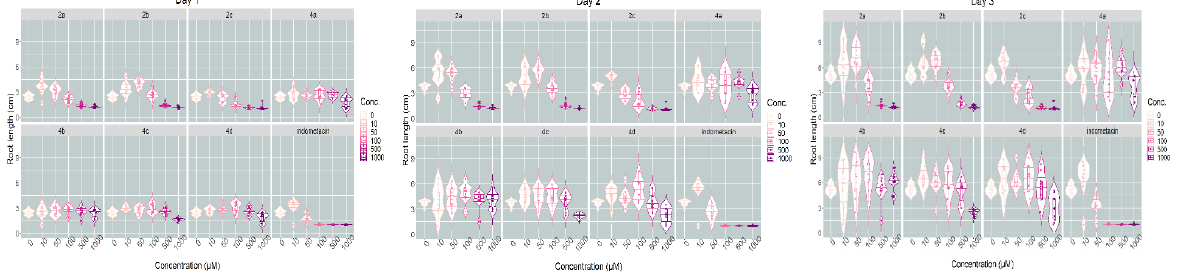
Figure 5. Violin plots showing the variations in Triticum’s main rootlet length under the influence of the substances tested at different concentration levels and day of measurement.